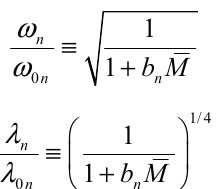
( a ) ( b ) Figure 2. Plots of ( a ) translational inertia coefficient, ( ) β ξ , for an attached particle at position ( ) n coefficient, 0 r